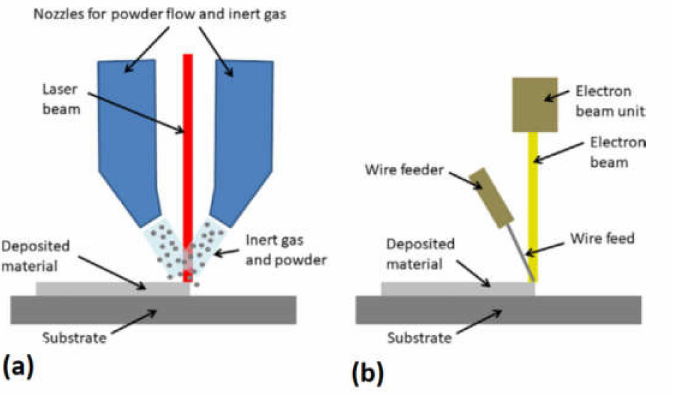
Figure 2. Schematics of two direct energy deposition (DED) systems: ( a ) laser with powder feedstock and ( b ) an electron beam with wire feedstock [31]; with permission from